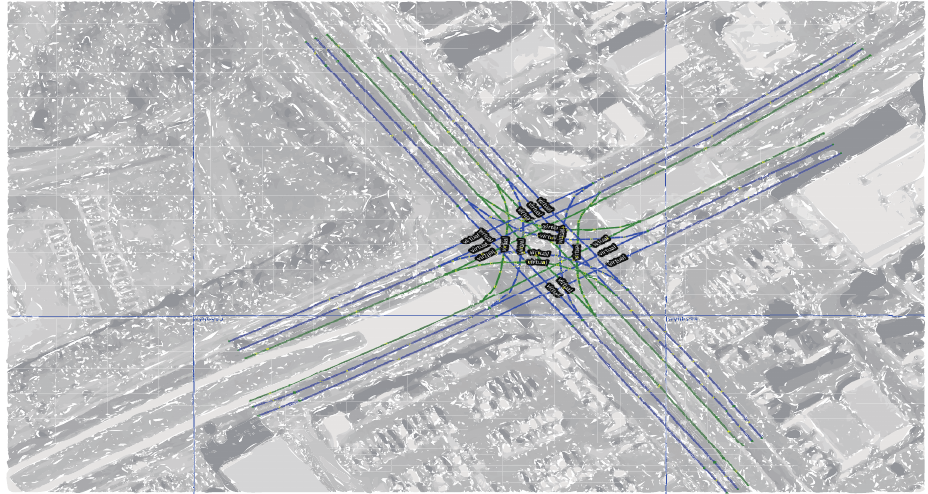
Figure 10. (Scenario-1) An example of an intersection center (geographical data from OSM [36] are illustrated as a superimposed background image).